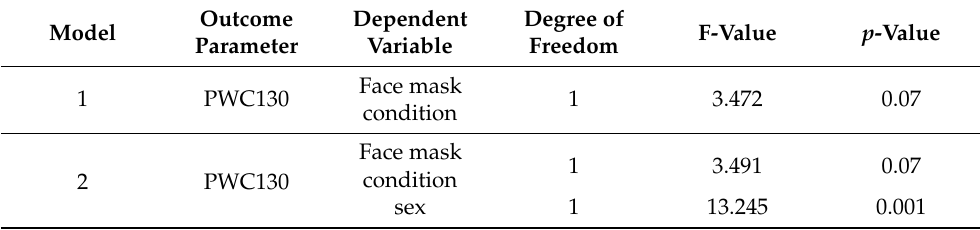
Table 2. Comparison between the no mask and MedMask